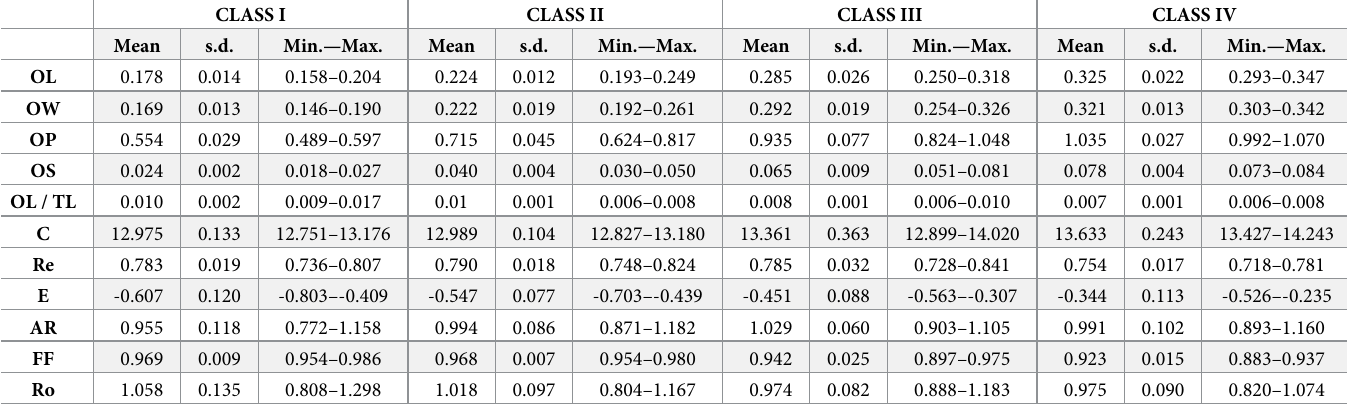
Table 2. Morphometric mean values of lapilli , standard deviation (s.d.) and minimums (Min.) and maximus (Max.) values divided for the size classes investigated: Maximum otolith length (OL, mm), the maximum otolith width (OW, mm), otolith perimeter (OP, mm) and otolith surface (OS, mm 2 ), the ratio of otolith length to the total fish length (OL/TL), circularity (C = OP 2 /OS), rectangularity (Re = OS/[OL × OW]), ellipticity (E = OL–OW/OL+OW), aspect ratio (AR = OW/OL%), form factor (FF = 4 π OS/OP 2 ) and roundness (Ro = 4OS/ π OL 2 ).